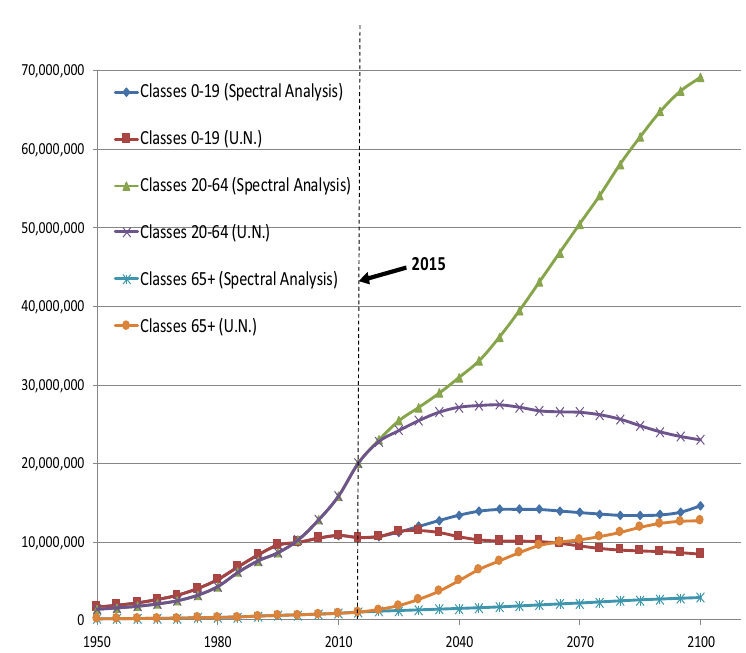
Figure 13. Three combined age groups, the 0-19, 20-64, 65 þ constituting KSA ’ s pyramid of ages for